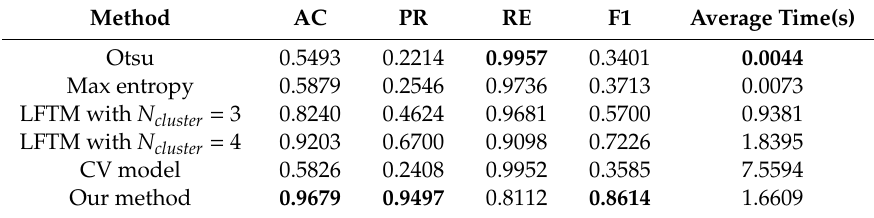
The bold text shows the best result for each column.